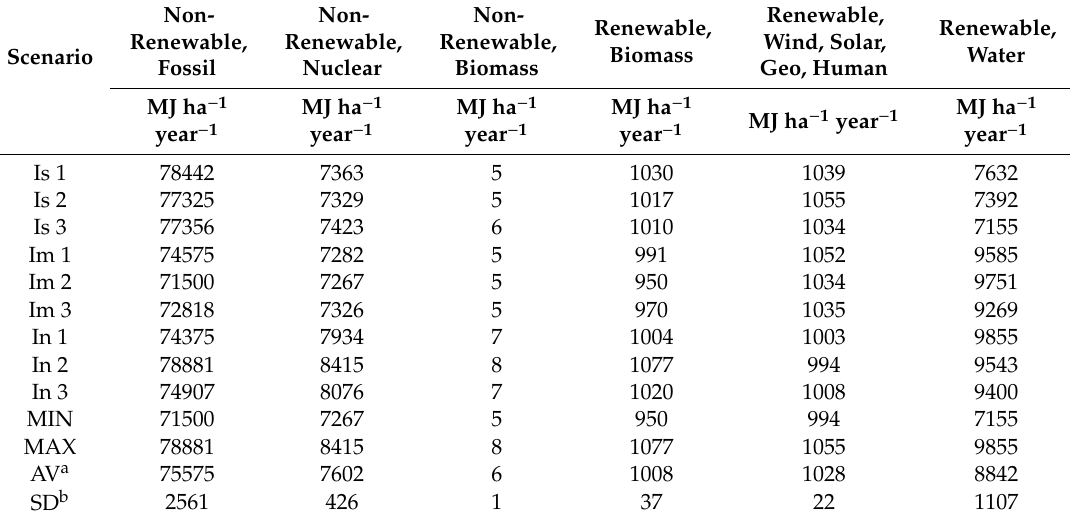
Table 4. Energy results in the integrated farming system.